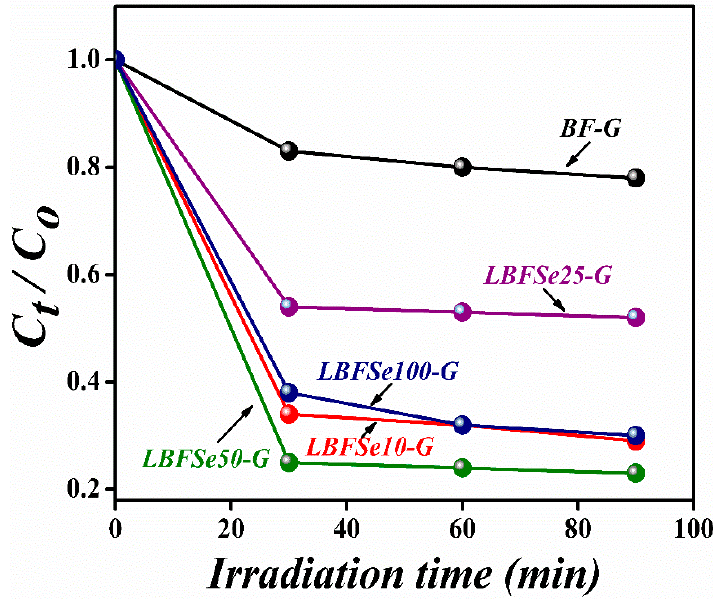
Figure 7. The photo-degradation efficiencies of Congo Red (CR) in the presence of, (a) BFO–G, (b) LBFSe10–G, (c) LBFSe25–G, (d) LBFSe50–G, and (e) LBFSe100–G.